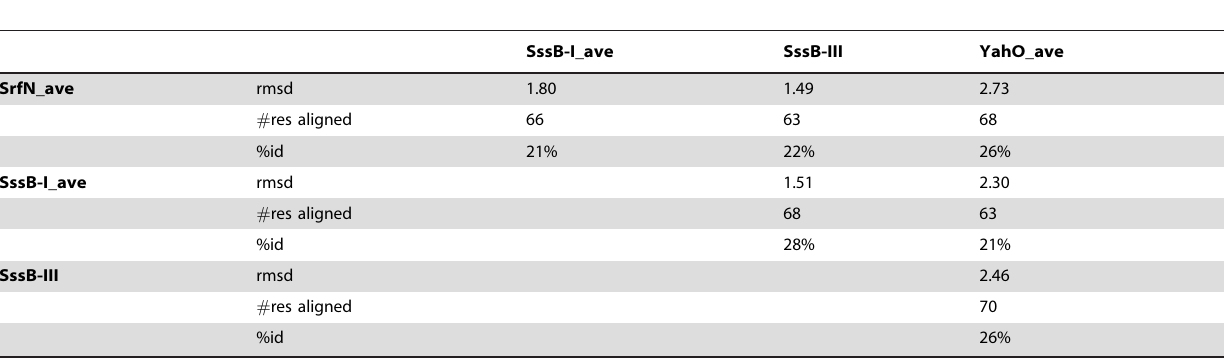
Table 3. Comparison of DUF1471 structures. Pairwise Dali [20] was used to align structures and calculate RMSD. The average NMR structures were used for purposes of structure comparison.